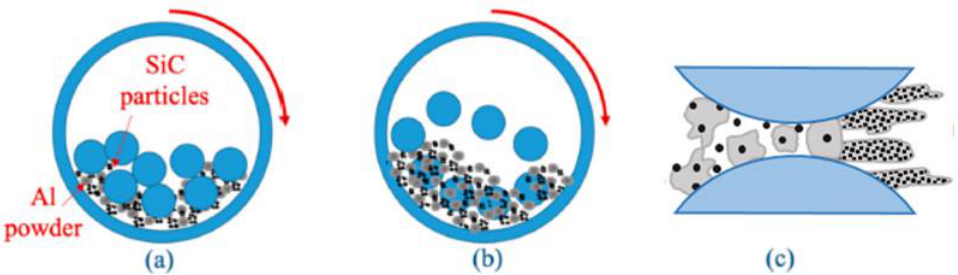
Figure 6. A schematic of the producibility of LHSBM-Al powder; ( a ) stage 1, ( b ) stage 2, and ( c ) stage 3.